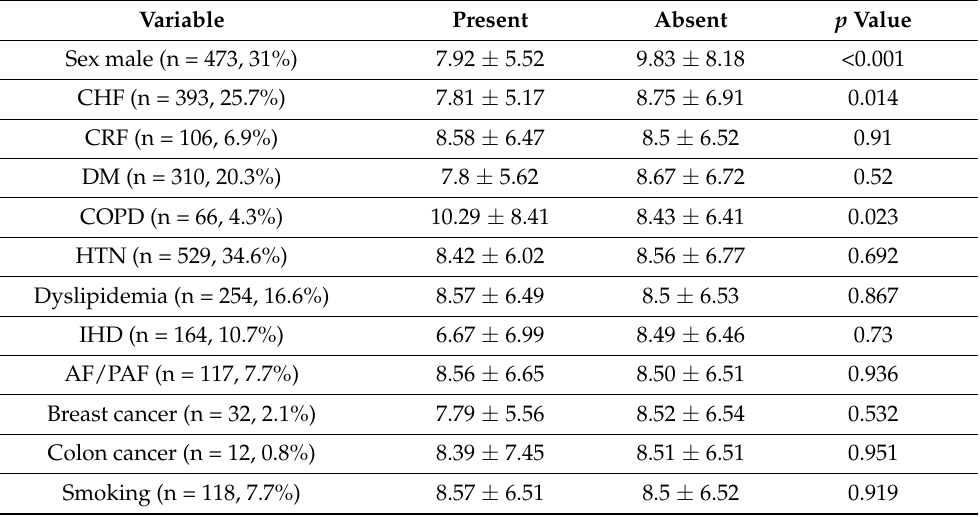
Table 1. Neutrophile/lymphocyte ratio (NLR 0 ) upon presentation of 1551 elderly patients with a proximal femur fracture. Values are presented as a mean ± standard deviation. CHF, chronic heart failure; CRF, chronic renal failure; DM, diabetes mellitus; COPD, chronic obstructive pulmonary disease; HTN, hypertension; IHD, ischemic heart disease; AF, atrial fibrillation; PAF, paroxysmal atrial fibrillation.